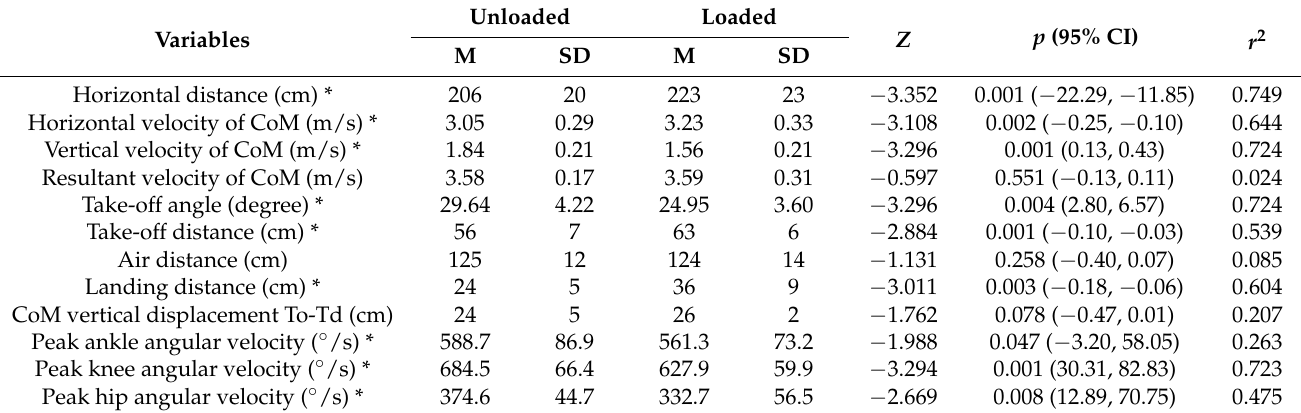
Table 1. Kinematic variables in standing broad jumps.